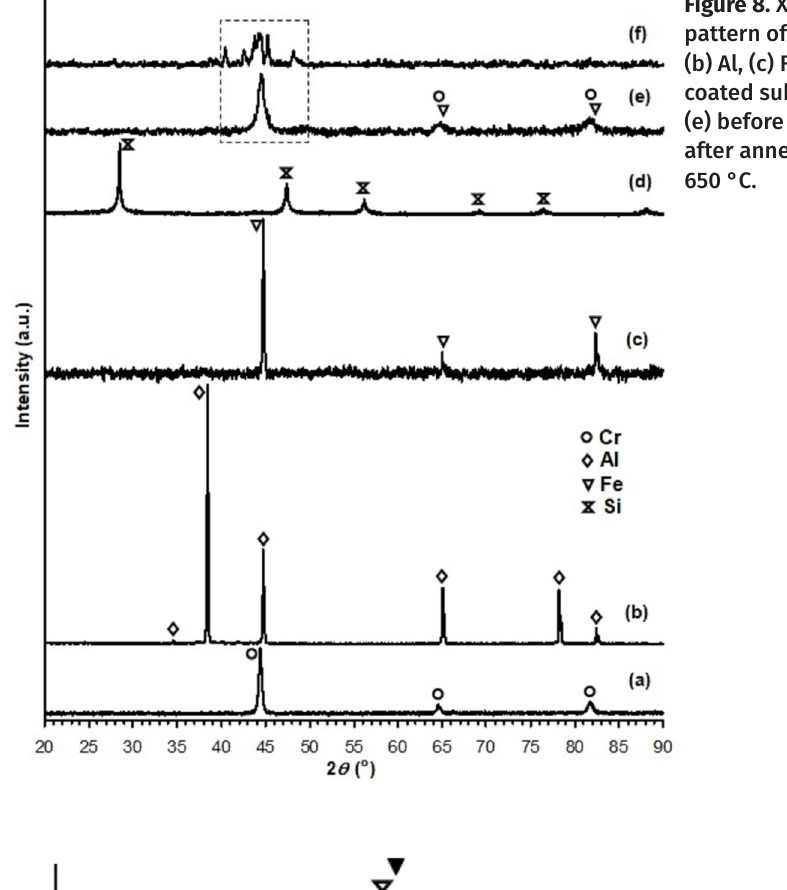
Figure 9. XRD pattern details of coated substrate without and with annealing in Figure 7e and Figure 7f,